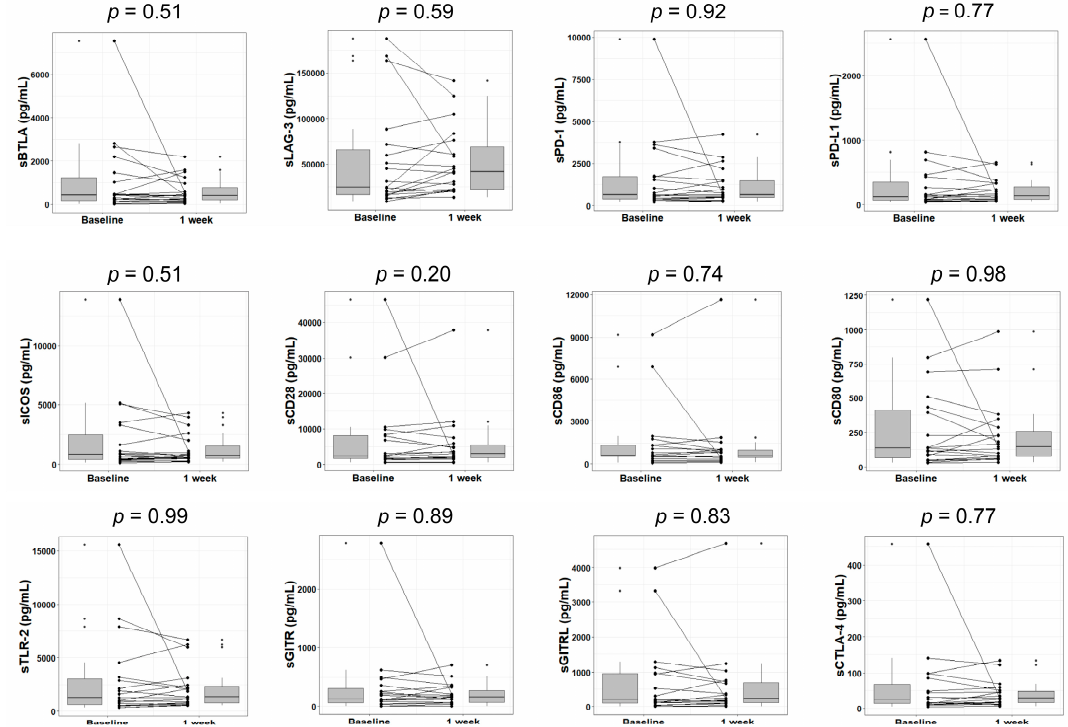
Figure A1. Changes in soluble immune checkpoint protein levels after 1 week of lenvatinib treatment. Box plots display the sBTLA, sLAG-3, sPD-1, sPD-L1, sICOS, sCD28, sCD86, sCD80, sTLR-2, sGITR, sGITRL, and sCTLA-4 levels in HCC patients at baseline and Week 1 of treatment. The vertical lengths of the boxes indicate the interquartile ranges and the lines in the boxes suggest the median values, while the error bars show the minimum and maximum values (range). The Wilcoxon signed-rank test was used.